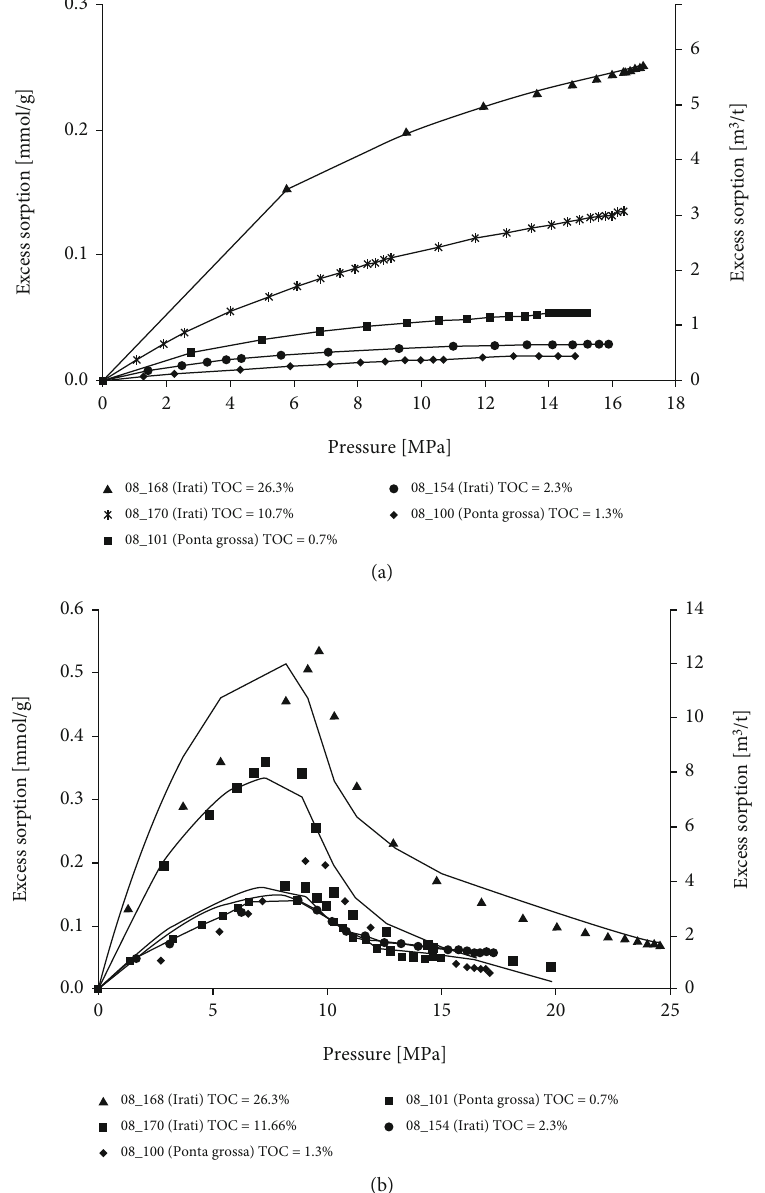
and (b) CO on crushed dry shale samples of the Parana Basin in 4 2